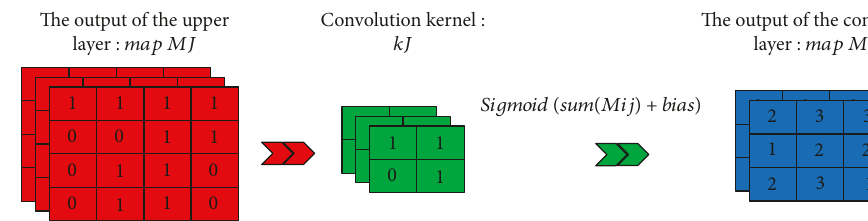
Figure 5: The schematic diagram of the convolution process.